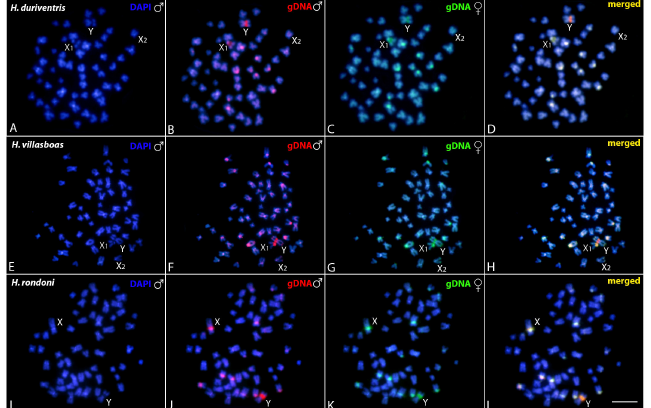
Figure 5. Mitotic chromosome spreads of males H. duriventris ( A–D ), H. villasboas ( E–H ) and H. rondoni ( I–L ) after intraspecific CGH procedures. Male- and female-derived genomic probes were hybridized together for each species. First column ( A , E and I ): DAPI images (blue); Second column ( B , F , and J ): hybridization pattern of the male-derived probe (red); Third column ( C , G , and K ): hybridization pattern of the female-derived probe (green). The fourth column ( D , H , and L ): merged images of both genomic probes and DAPI staining. The common genomic regions for males and females are depicted in yellow. Sex chromosomes are indicated. Bar = 10 µ m.